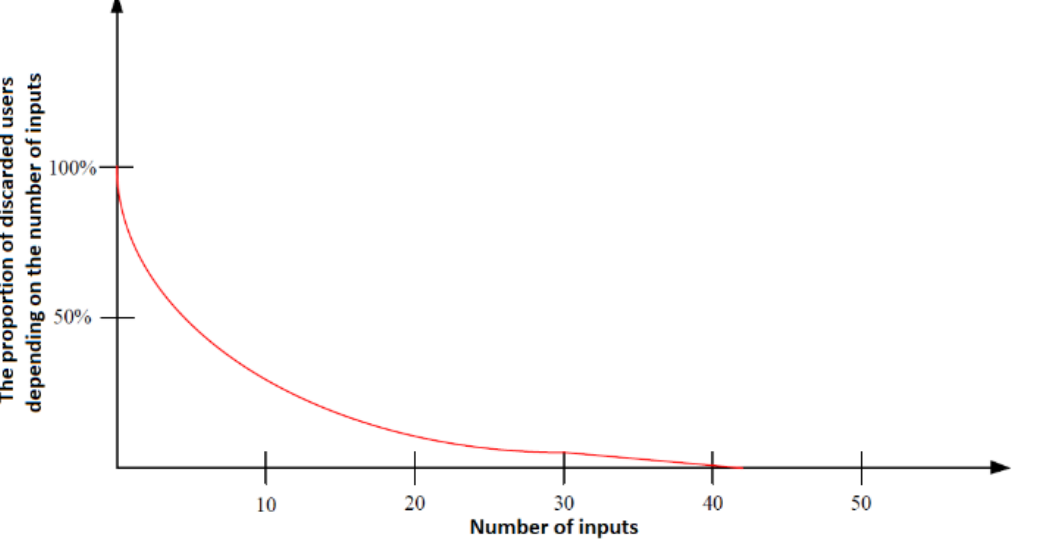
Figure 4. Looking for a “near” optimal solution for the service system number of inputs by consid ‐ ering the defined percentage threshold of allowed rejected users for a specific scenario (theoretical example).